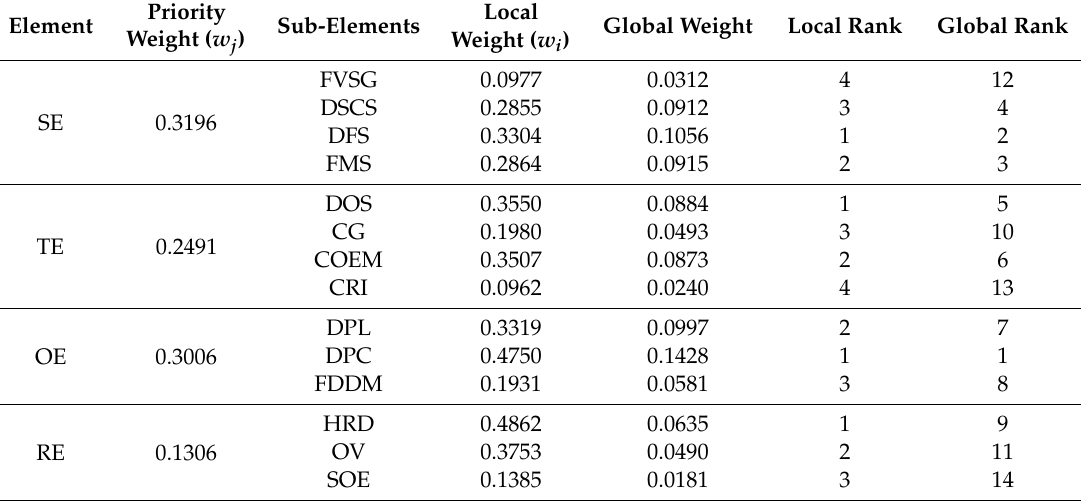
Table 10. Results on elements and sub-elements